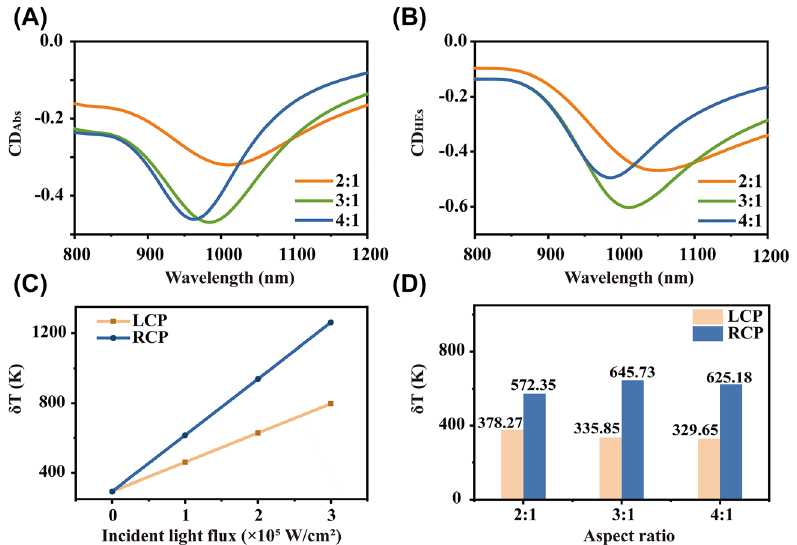
Figure 2: Chiral effect of LCNs with different aspect